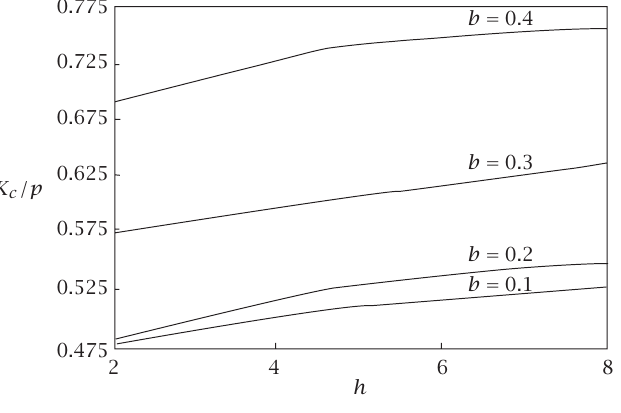
b /p versus h at c